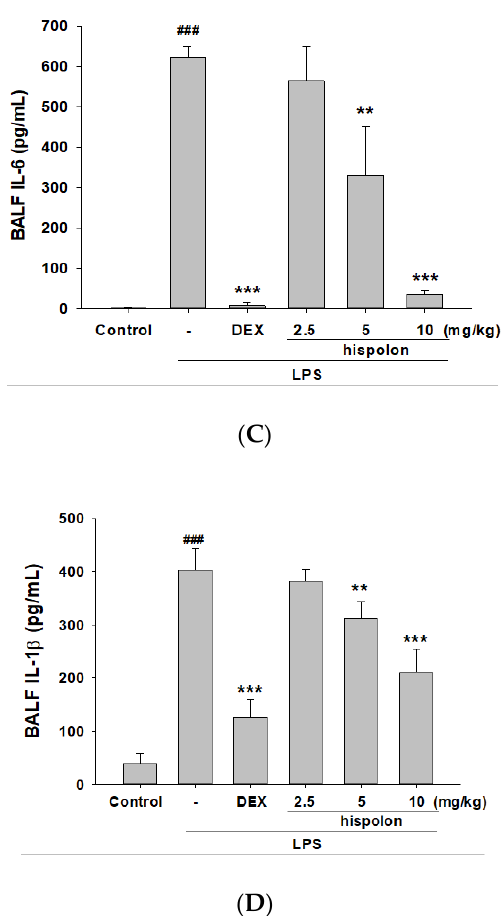
Figure 3. Hispolon decreased ( A ) NO, ( B ) TNF- α , ( C ) IL-1 β and ( D ) IL-6 in the BALF. Pro-Inflammatory cytokine were measured after LPS challenge by ELISA. Data are represented as means ± S.E.M. (n = 6). ### p < 0.001 versus the control group. ** p < 0.01 and *** p < 0.001 versus the LPS group.